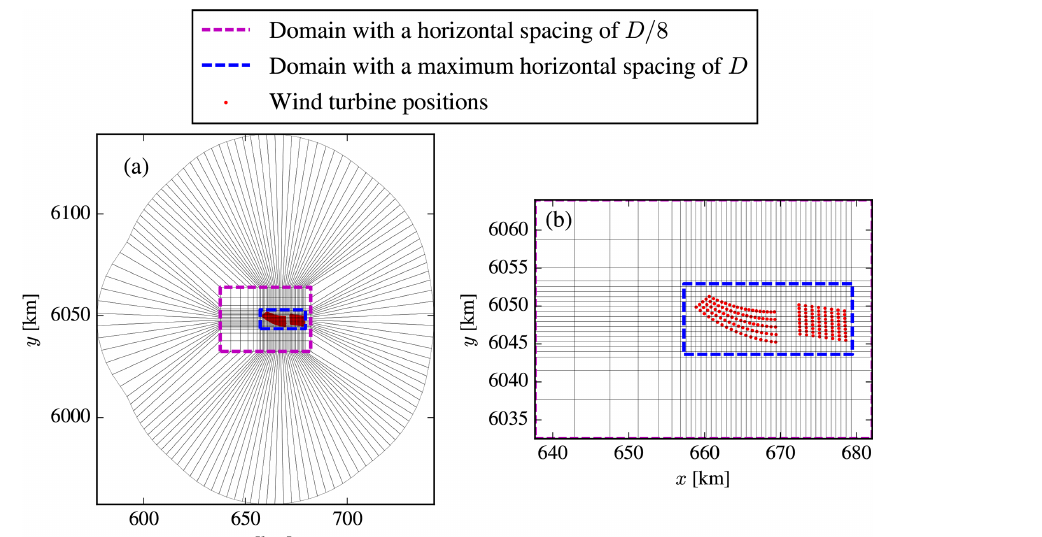
Figure 4. Surface grid of RANS simulations where every 64th grid line is shown. Two inner regions are marked by the magenta and blue dashed boxes. Wind farm layouts are shown as red dots. Panel (b) is a zoomed view of (a)